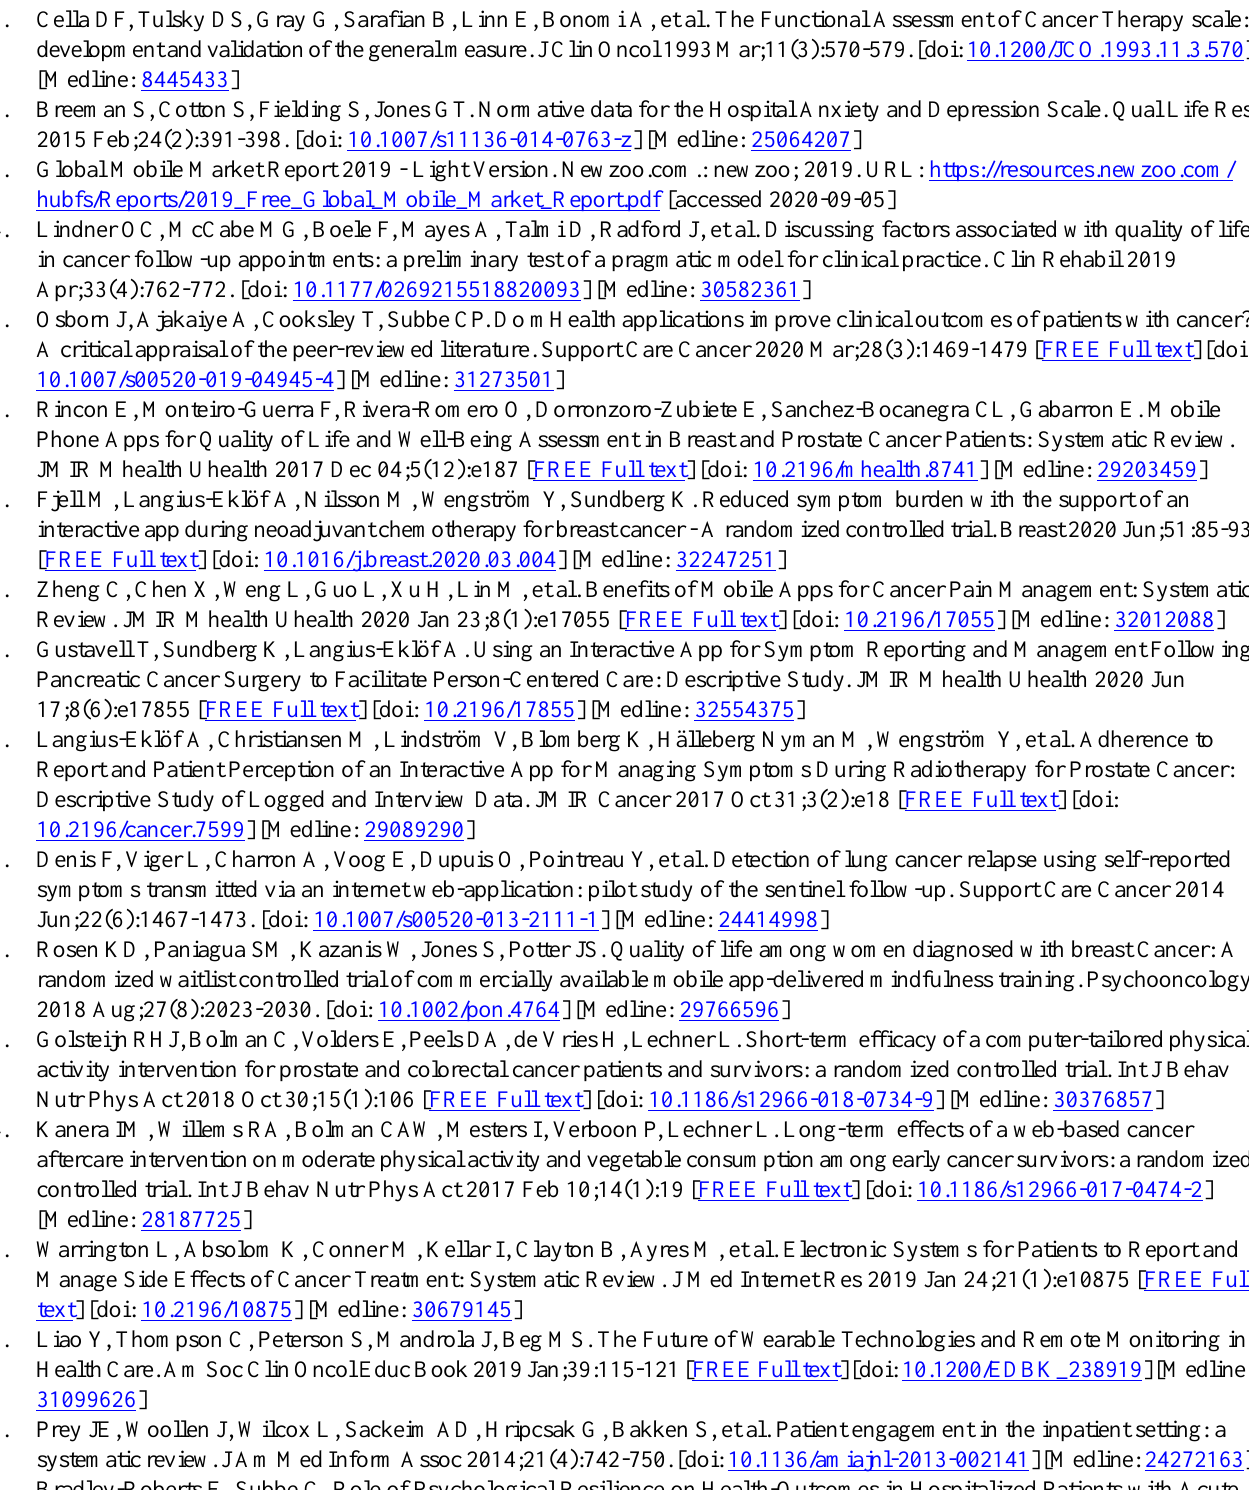
FACT-G: General version of the Functional Assessment of Cancer Therapy UKONS: United Kingdom Oncology Nursing